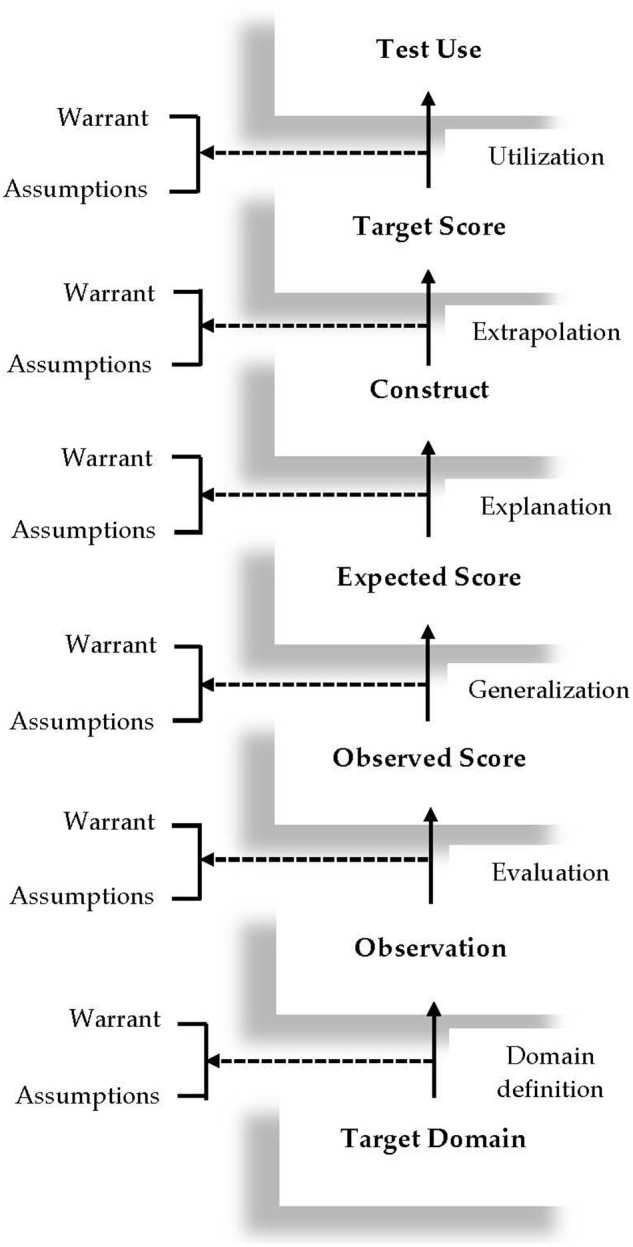
The argument-based validation framework (adapted from Chapelle et al., 2008, p. 18).